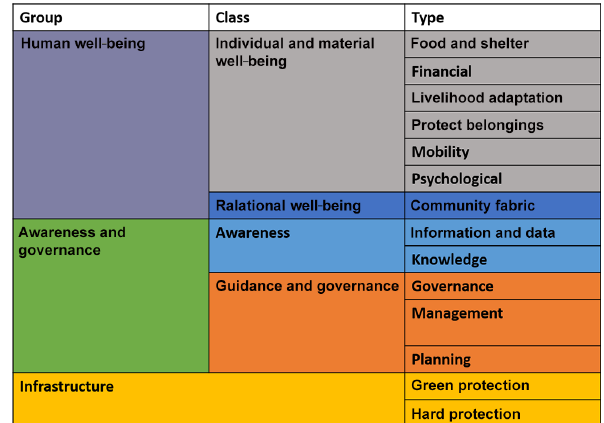
Figure 1. Response examples were organized through a grounded theory approach resulting in a typology of 15 types falling within five classes, within three aggregated groups of